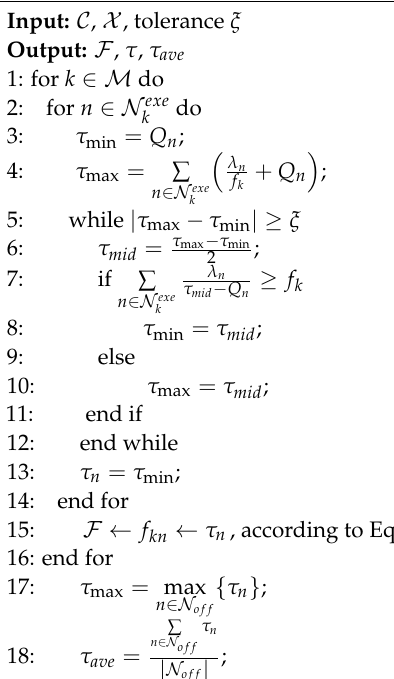
Algorithm 2: Computing Resource Allocation based on Fairness